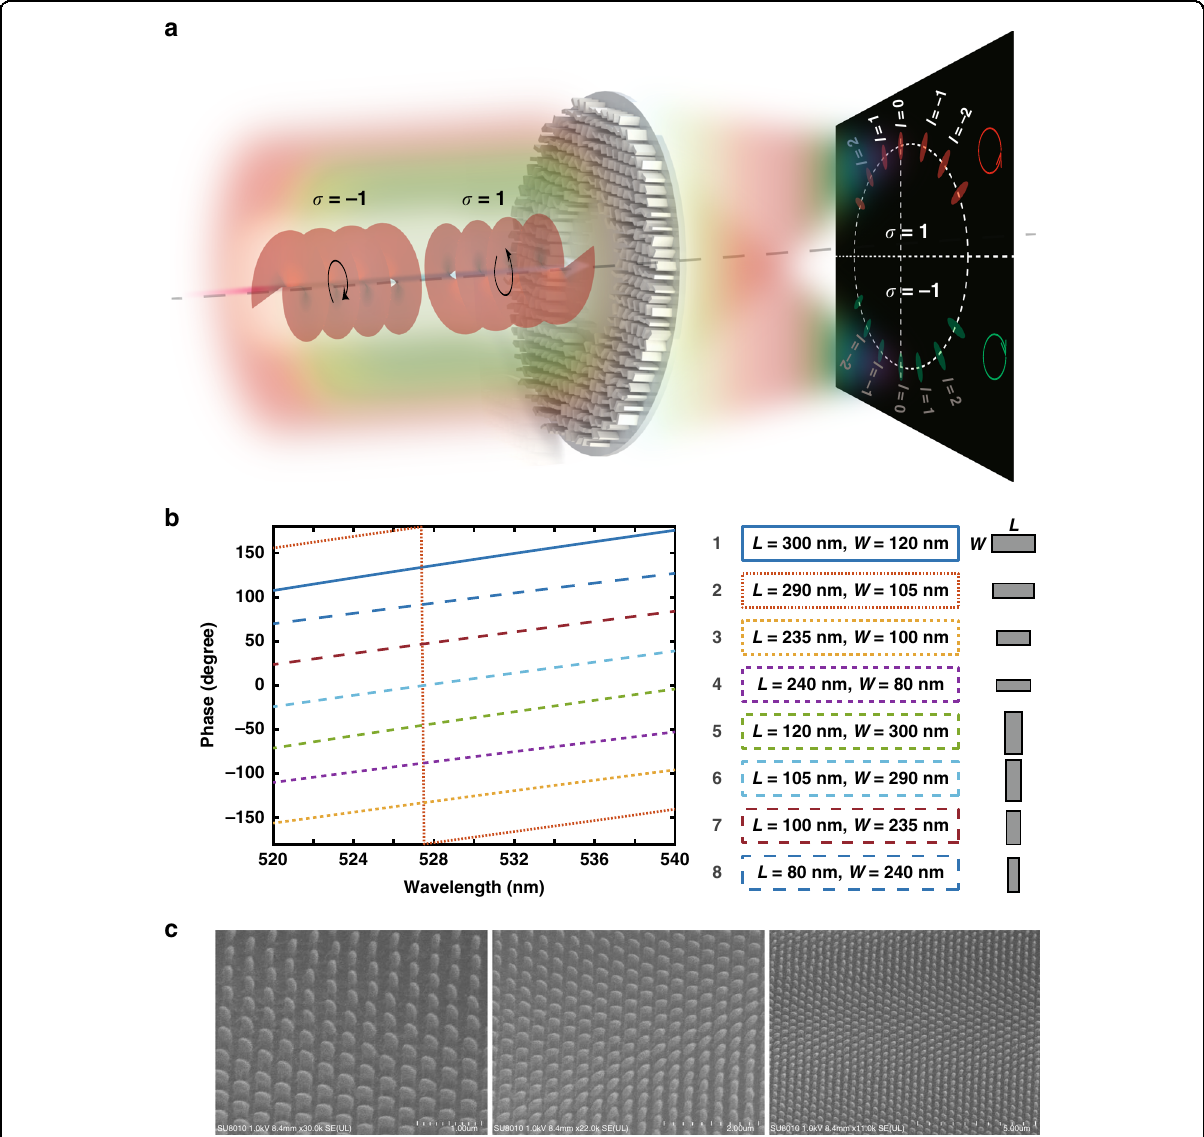
Fig. 3 Single spin-decoupled metasurface-based PMTs for simultaneous SAM and OAM sorting. a Schematic of a spin-decoupled metasurface that merges the geometric phase and dynamic phase for simultaneous SAM and OAM sorting via spin-controlled PMTs. Vortex beams with different spins are transformed into focusing patterns on two separated halves of the screen on a transverse focal plane with topological charge-dependent azimuthal rotations. b Eight unit cells of the spin-decoupled metasurface and their corresponding phase modulation around a wavelength of 532 nm. c Perspective-view SEM images of the fabricated spin-decoupled